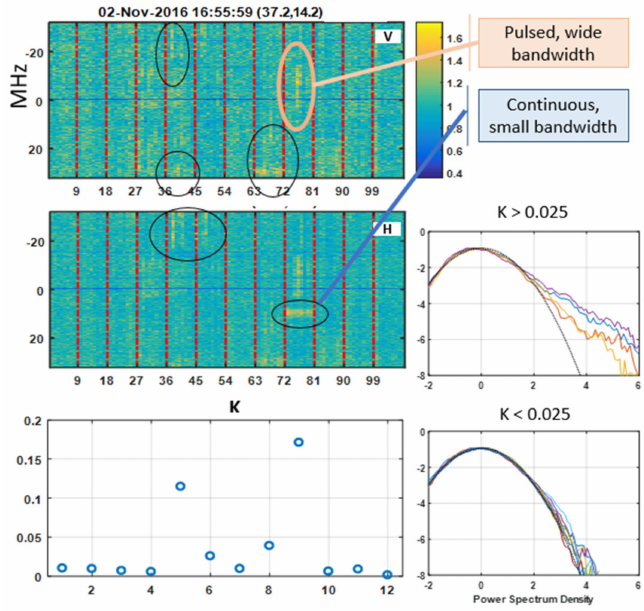
Figure 6. Example of detection of low-power RFI. Top and middle panels on the left: spectrograms for V and H polarizations. Each vertical strip corresponds to the 9 pulses at the beginning of a bursts, all coming from the same sub-swath (IW1). The strongest RFI are encircled. Lower left panel: plot of KL divergence for each burst ( x -axis define the burst number, and it has been aligned with the spectrograms above). Right panels: histograms, in log scale, and fitting normal PDF, for the bursts with K > 0.025 and K <